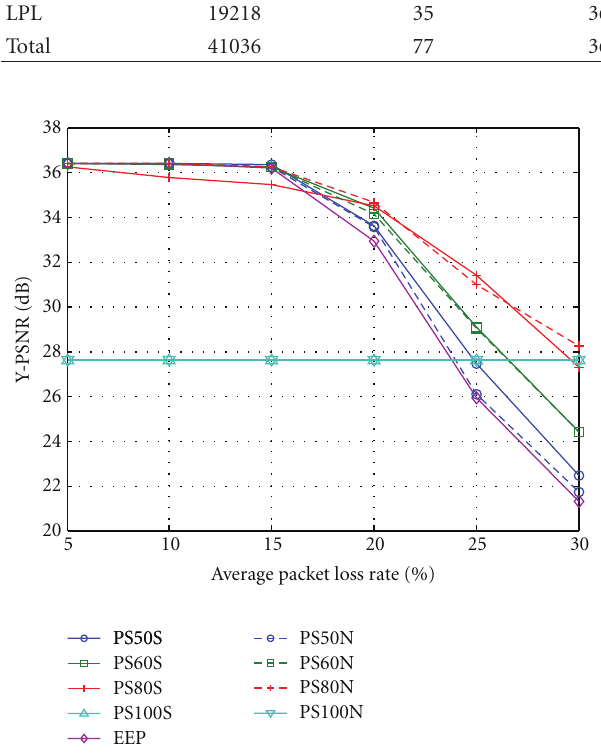
Figure 4: Comparison between systematic and nonsystematic EW RLC codes.